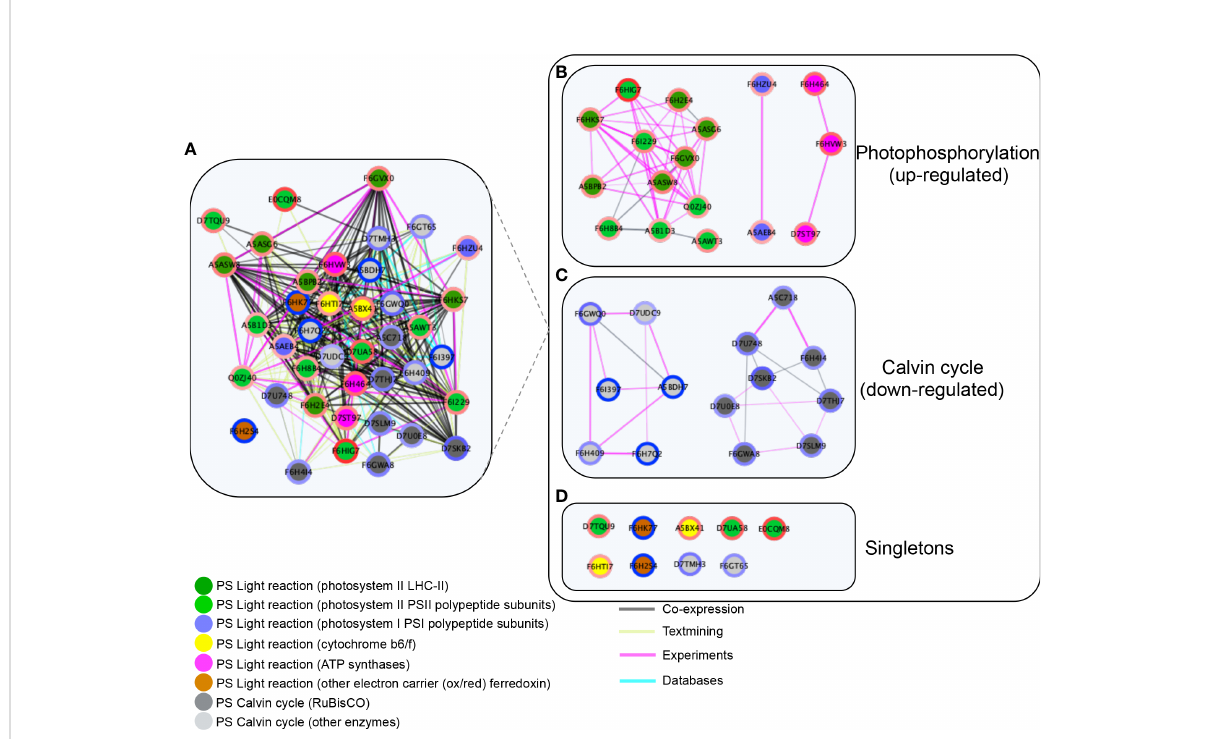
FIGURE 6 Network protein – protein interactions of differentially accumulated proteins (DAPs) in the chloroplasts of Vitis vinifera cv. Vinhão exocarp at the mature stage (E-L 38) vs. the green stage (E-L 34). (A) Functional association cluster network. Network limited to “ physical interaction ” clusters. (B) Photophosphorylation-involved proteins; (C) Calvin cycle involved proteins, and (D) Singletons. LogFC ratios of protein abundance between the green and mature stages were mapped around the nodes using a blue (negative) and red (positive) color gradient. The inner nodes were colored according to the MapMan bins. The edge scores are visualized by co-expression (black), co-occurrence (blue), experiments (pink), and textmining (light green). The network clusters were obtained using Markov clustering on the STRING network of proteins from panel (A) . Proteins were named according to their canonical